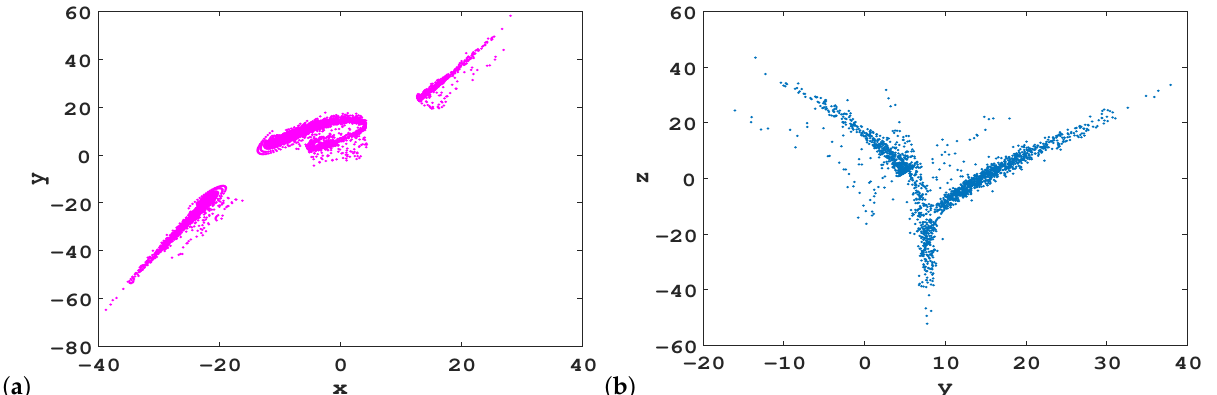
Figure 3. Two-dimensional Poincaré maps of the hyperchaotic attractor of system (2); ( a , b , c , k , m ) = ( 10,100,2.7, − 0.2,1 ) ; ( a ) on section z = 0; ( b ) on section x = 0.